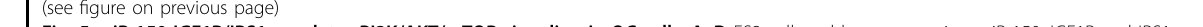
Fig. 5 miR-150-IGF1R/IRS1 regulates PI3K/AKT/mTOR signaling in OC cells. A – D ES2 cells stably co-expressing miR-150, IGF1R and IRS1 were established. A The protein levels of IGF1R and IRS1 determined by western blotting. Forced IGF1R and IRS1 expression restored the effects of miR-150 on cell proliferation ( B ), cell apoptosis ( C ), and cell migration ( D ) in ES2 cells. Scale bar: 200 µm. E Functional annotation clustering of proteins dysregulated by miR-150 in A2780 cells was shown. The ten most enriched groups according to GO molecular function analysis are ranked based on combined score. F The protein levels of IGF1R, IRS1, phosphorylated IRS1 (Ser307), phosphorylated AKT (Ser473), total AKT, phosphorylated mTOR (Ser2448), and total mTOR in ES2 cells transfected with siIGF1R or siIRS1 were determined by western blotting. G Effects of overexpression of miR-150 on protein levels of IGF1R, IRS1, phosphorylated AKT (Ser473), total AKT, phosphorylated mTOR (Ser2448), and total mTOR in OC cells. H Forced IGF1R and IRS1 expression partially restored the levels of phosphorylated AKT (Ser473) and phosphorylated mTOR (Ser2448) reduced by miR-150. The data are presented as the mean ± s.d. ** P < 0.01, *** P < 0.001, by Student ’ s t